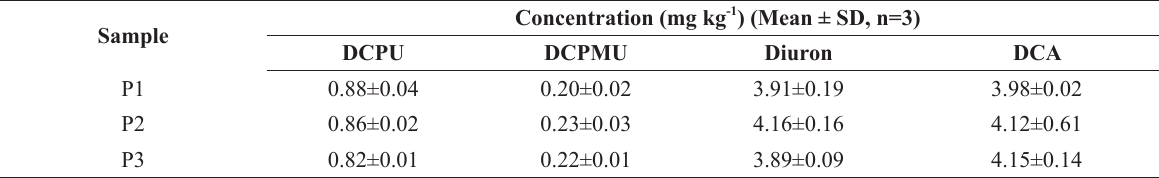
concentration of diuron and its metabolites in sugarcane soil samples.